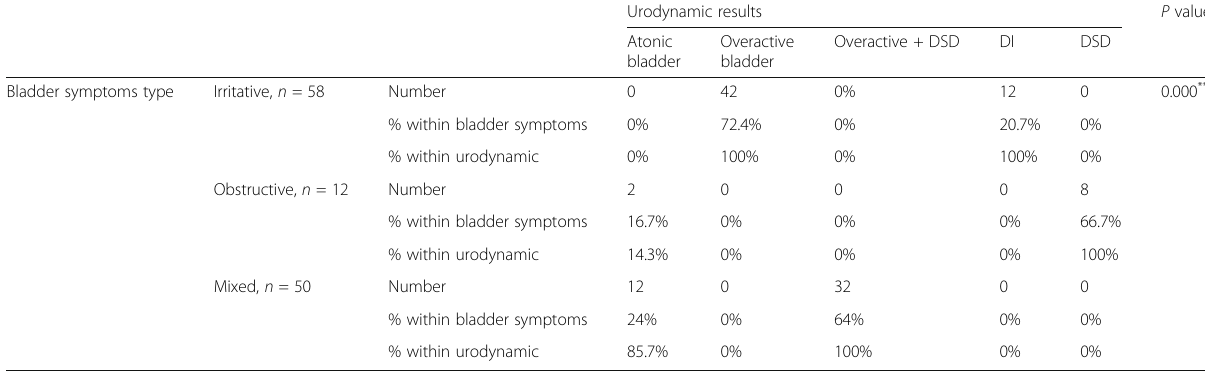
Table 4 Relationship of bladder symptoms type and urodynamic results